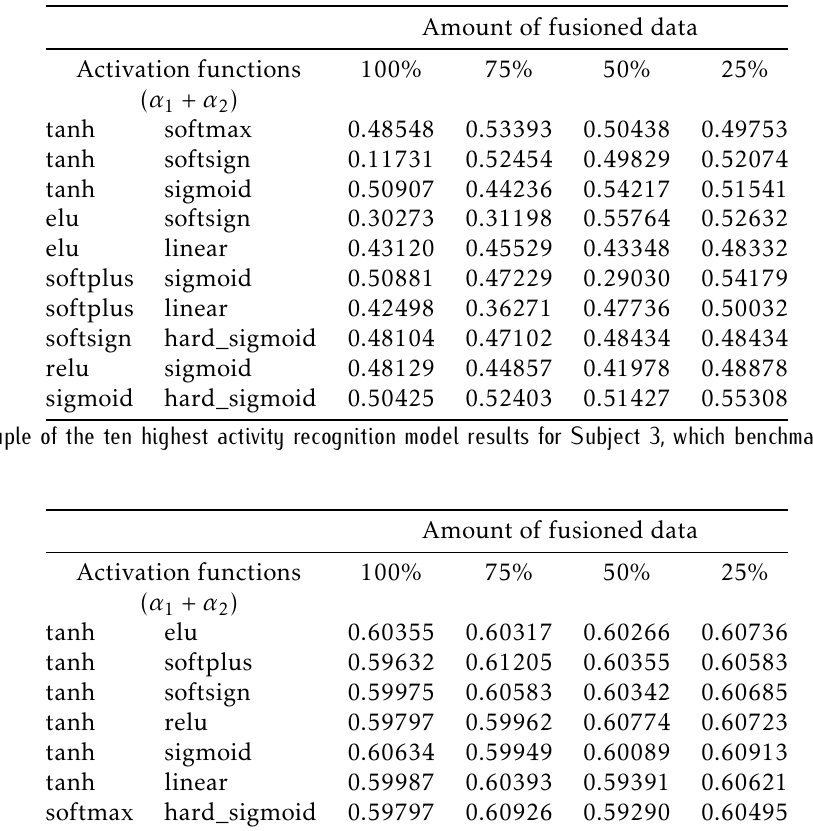
data is adopted. Thus, 25% of data benefits the models by building a more general